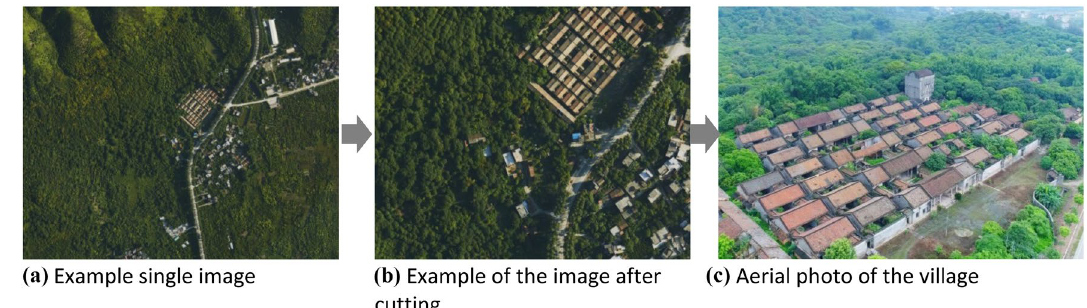
Fig. 3 Example of splitting single